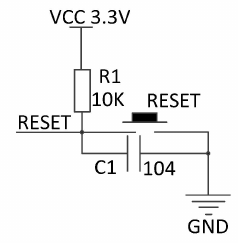
Figure 9. Reset module